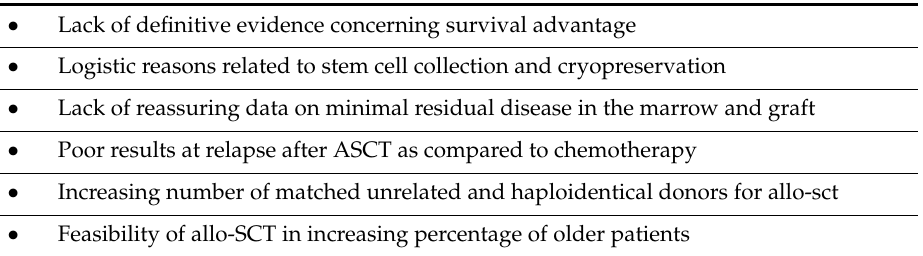
Figure 3. Comparison of days of neutropenia, thrombocytopenia and hospitalization between ASCT and three courses of a high dose of cytarabine (HDARAC); all di ff erences are statistically significant ( p < 0.01). Table 1. Factors related to the declining use of autologous transplantation in